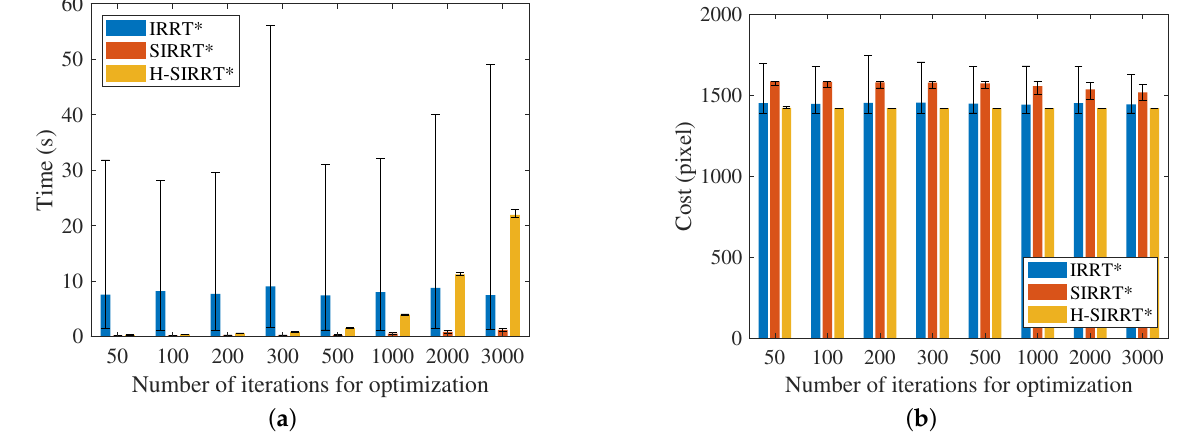
Figure 7. A comparison of the IRRT*, the SIRRT*, and the hierarchical path-planning using SIRRT* (H-SIRRT*): ( a ) Computational time. ( b ) Final